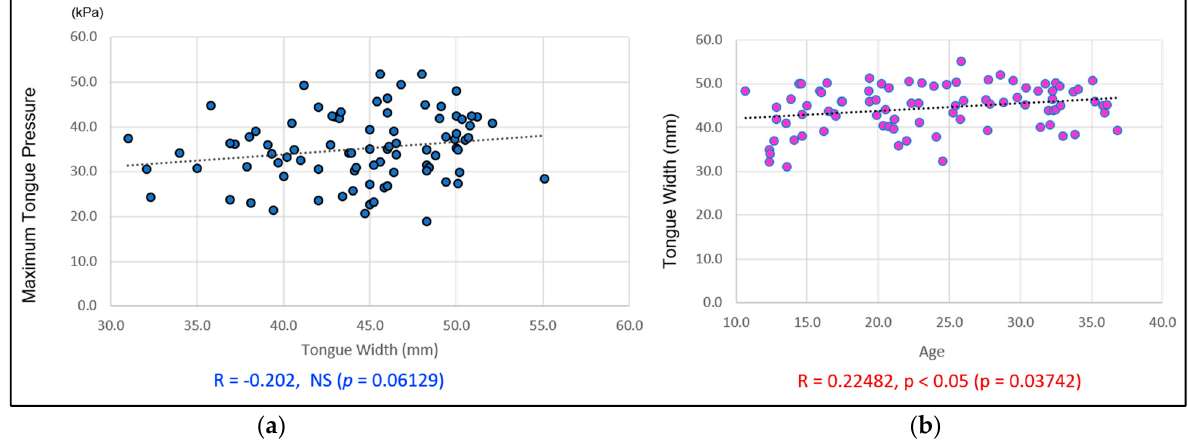
Figure 6. ( a ). Correlation between MTP and tongue width. ( b ). Correlation between tongue width and